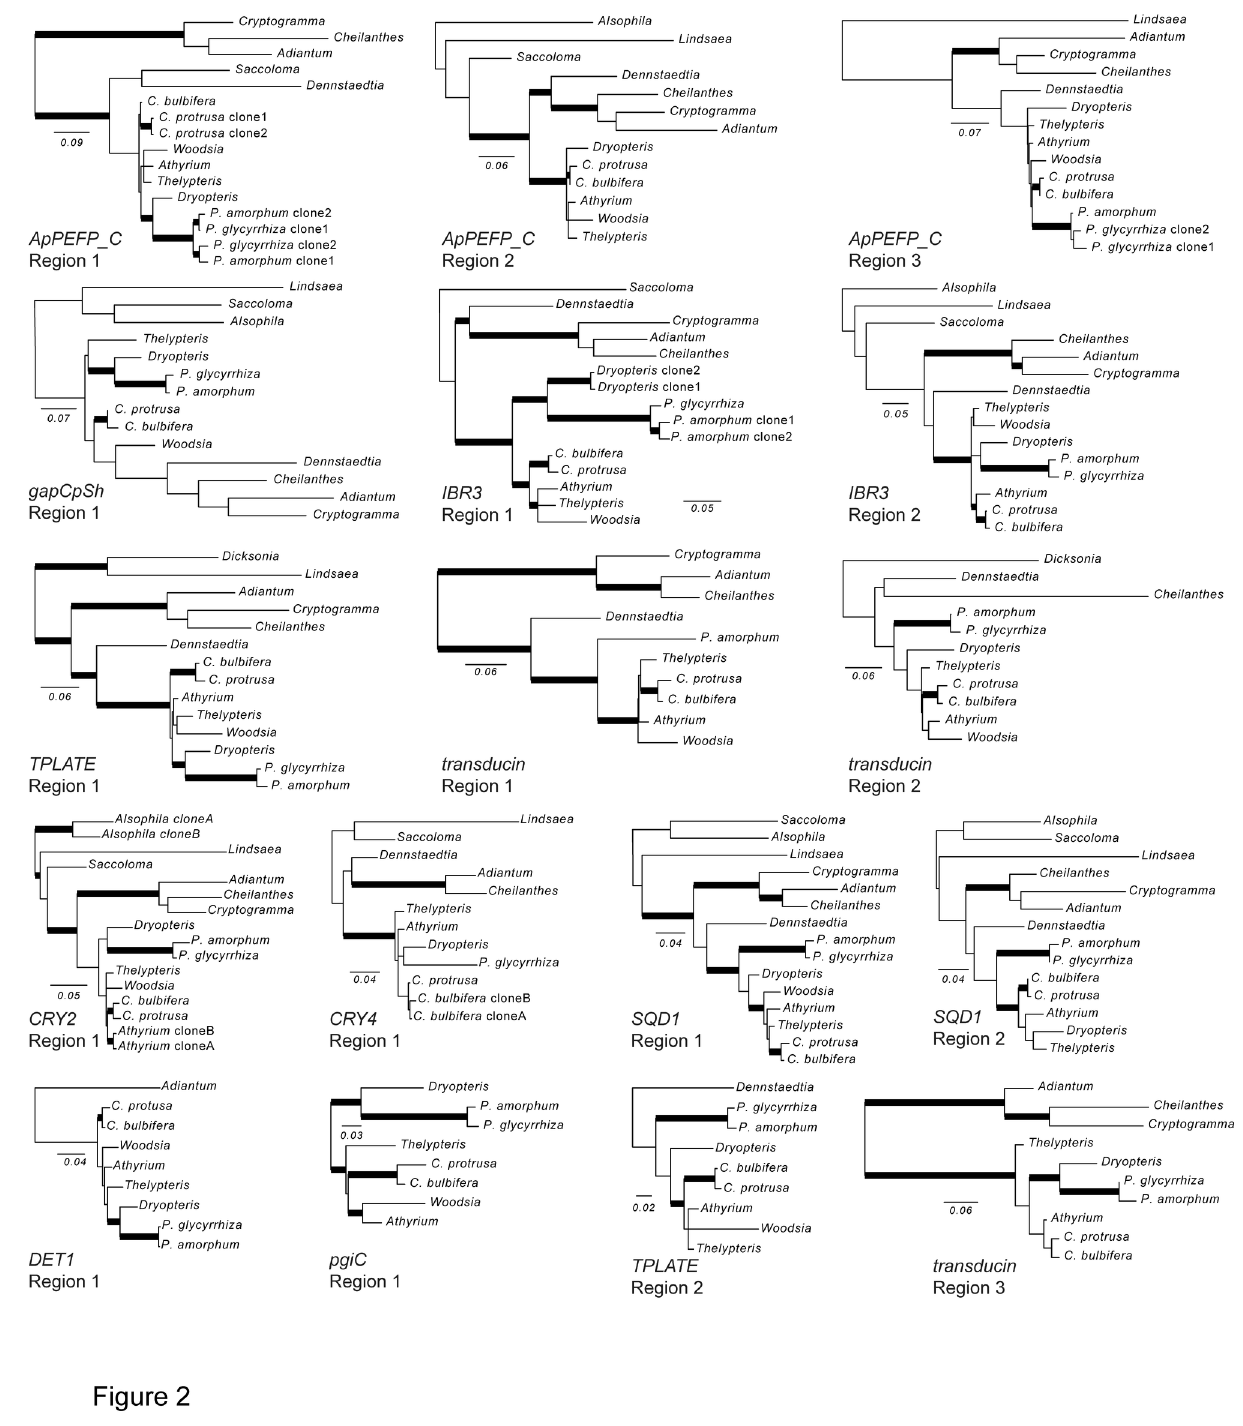
Figure 2. Maximum likelihood phylograms for each region, including only those taxa that were successfully sequenced from our 15-taxon genomic DNA test set. Bold branches indicate strong support (≥70% bootstrap support). Scale bars are in units of substitutions per site. In the taxon names, “ C .” and “ P .” refer to Cystopteris and Polypodium , respectively. These phylograms are unrooted, but oriented as if rooted by the Cyatheales (or our best guess, when the Cyatheales accession did not sequence successfully), when space permits.